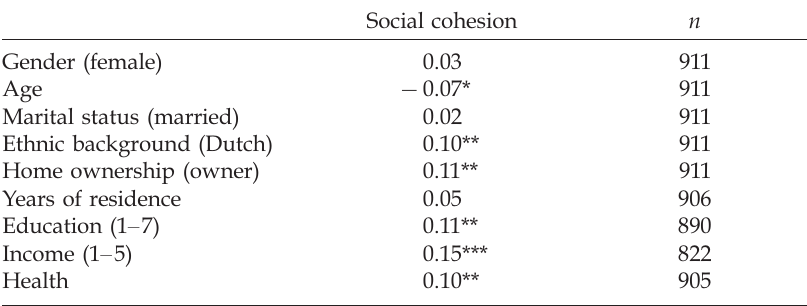
Table 2. Associations among indi v idual characteristics and social cohesion (r)